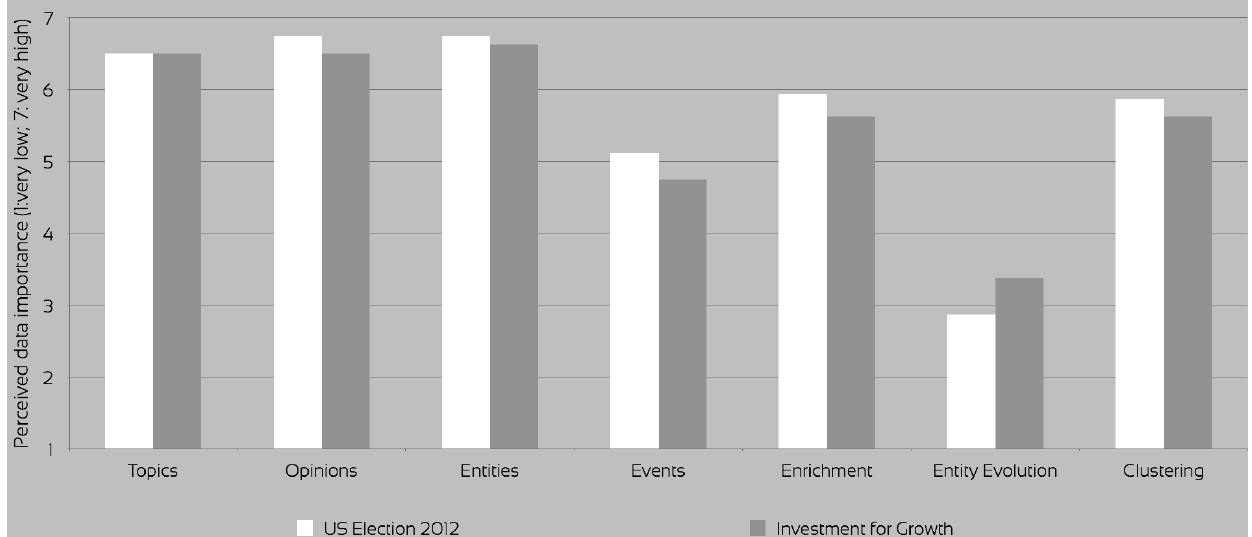
Figure 5. Perceived metadata importance.